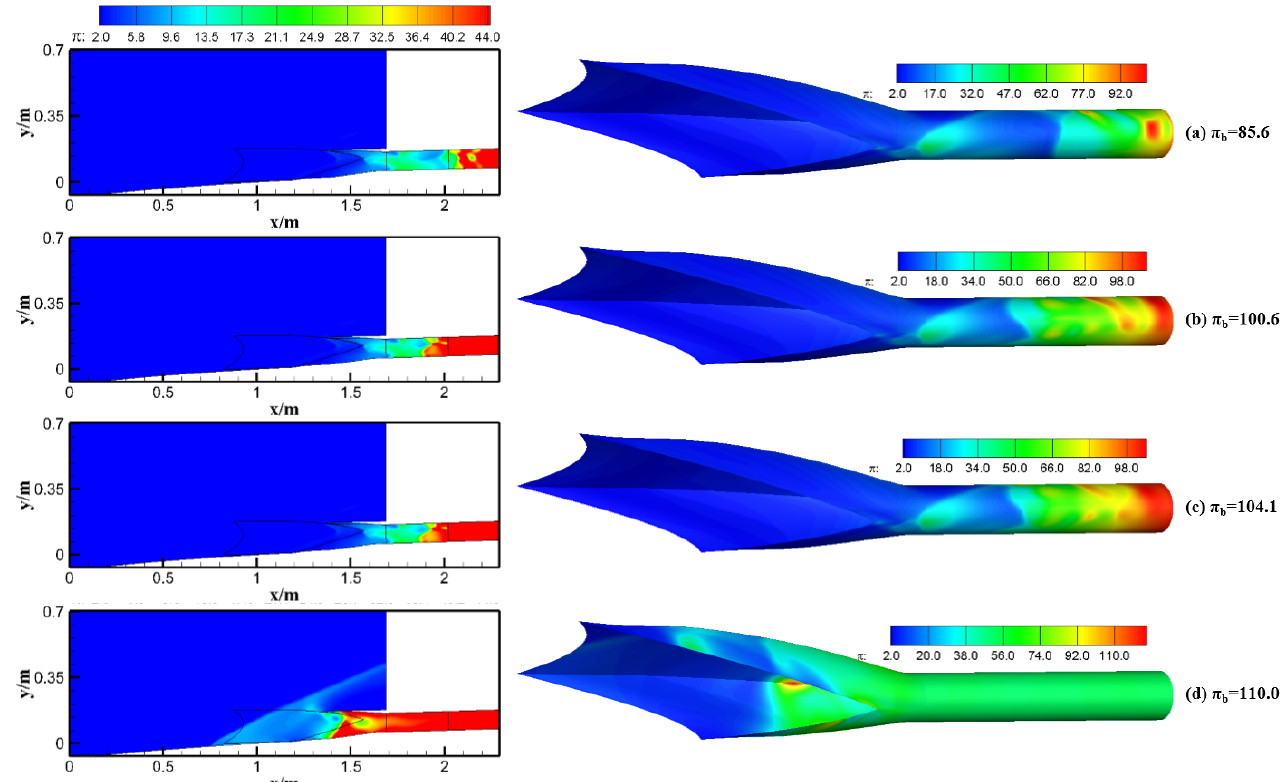
Figure 7. Pressure contours of the side-spillage integrated form ( π b = 85.6~110.0, Form 2).